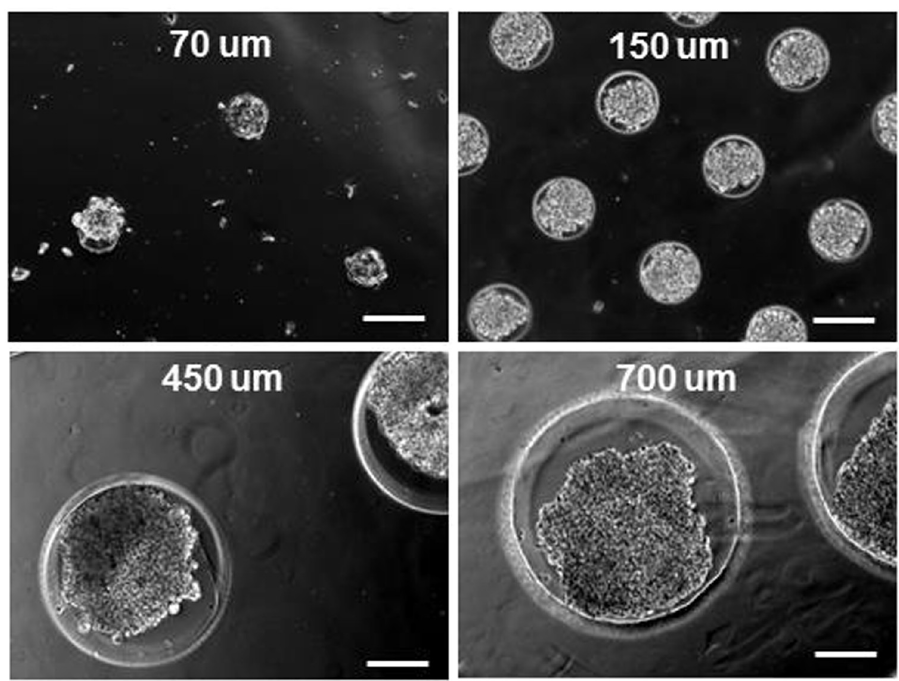
Fig 2. Phase contrast images of representative U251 glioma spheroids prepared in microwells of 70, 150, 450, and 700 μ m diameter. Scale bars represent 200 μ m.